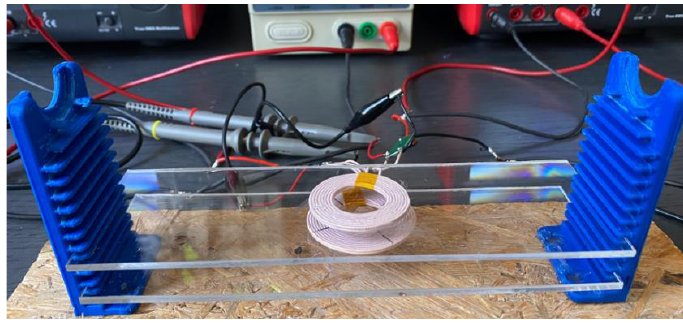
Figure 7. Stand for measuring the properties of the WPT system.